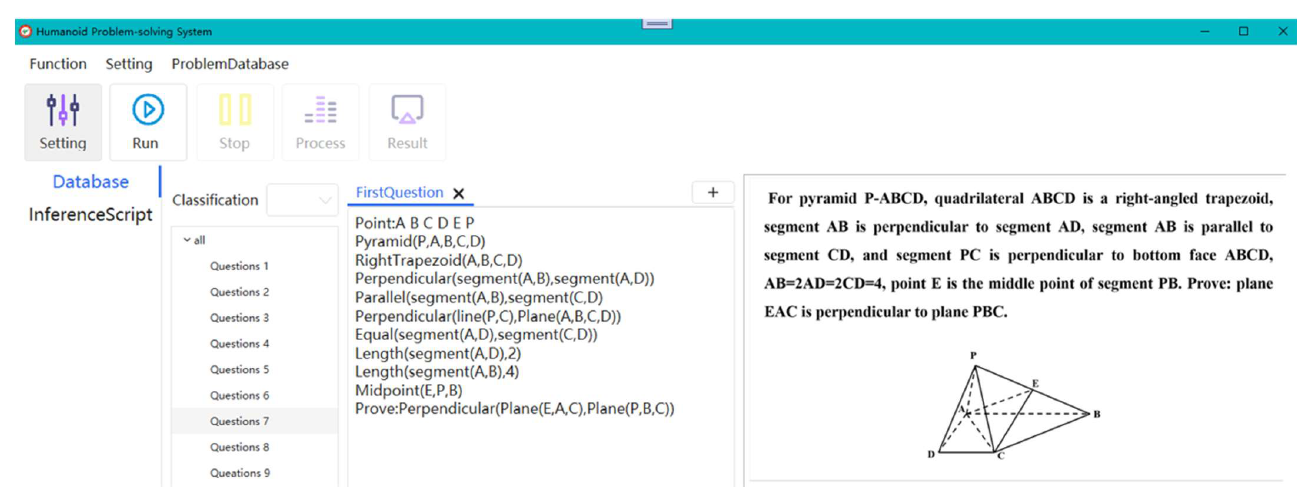
Figure 8. Interface of the automated geometry reasoning system.